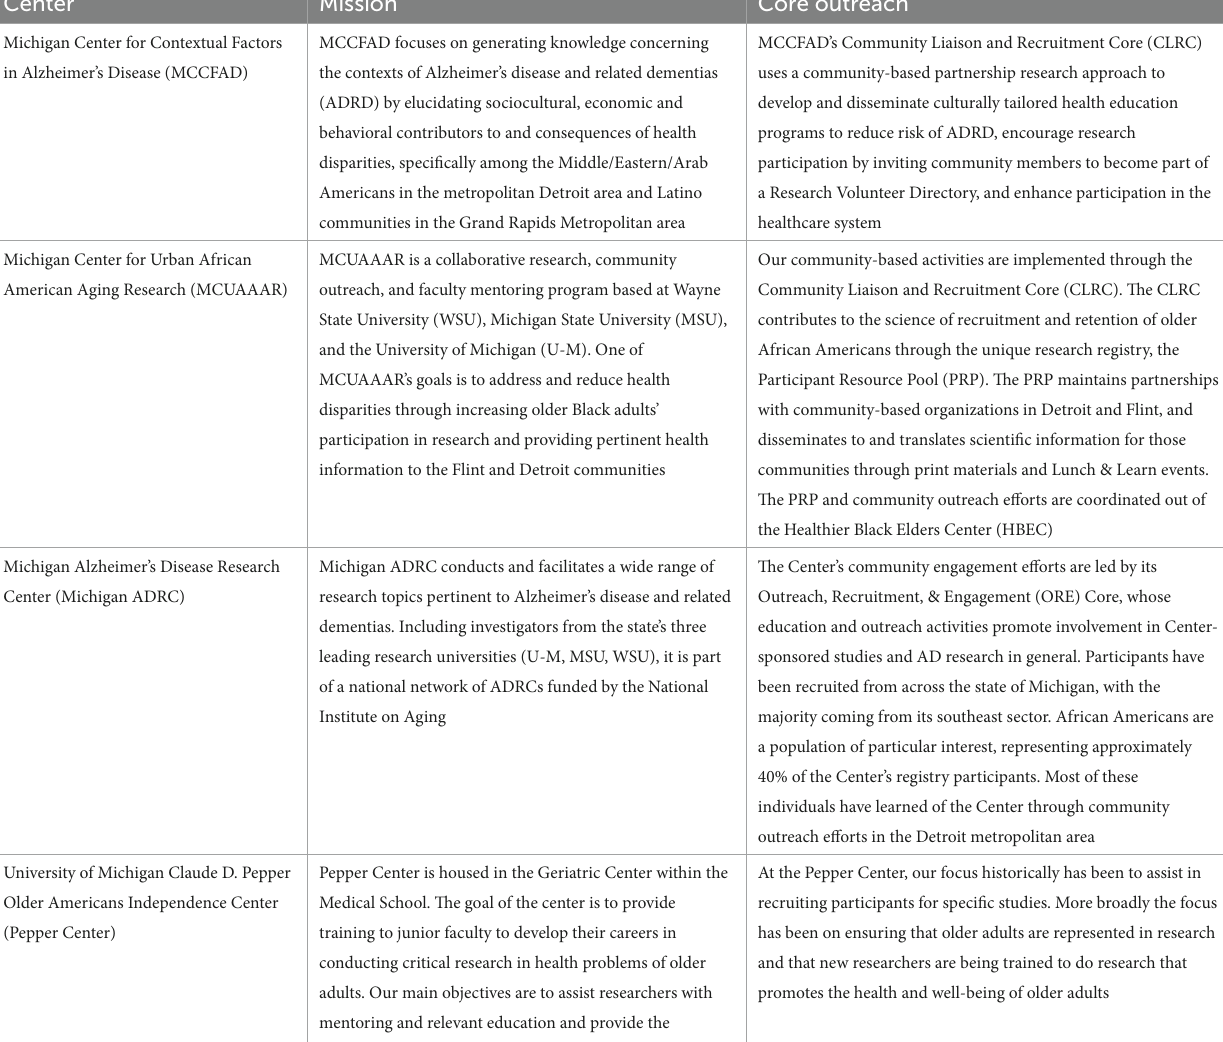
TABLE 1 Michigan National Institutes of Health funded